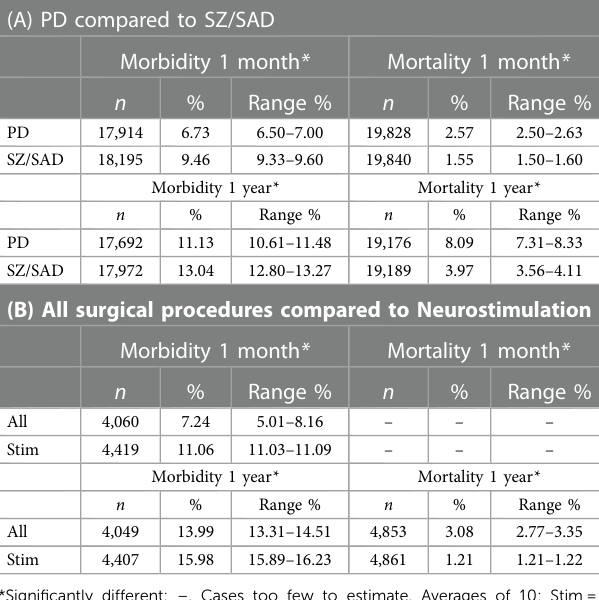
TABLE 3 Post-surgical morbidity ICD-10 codes (61) after 1 month and 1 year.